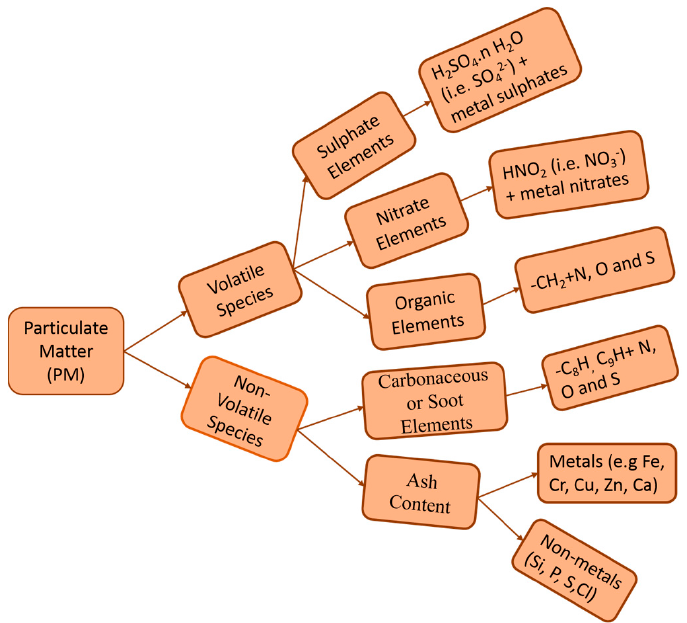
Figure 2. Conceptual model of typical PM composition.